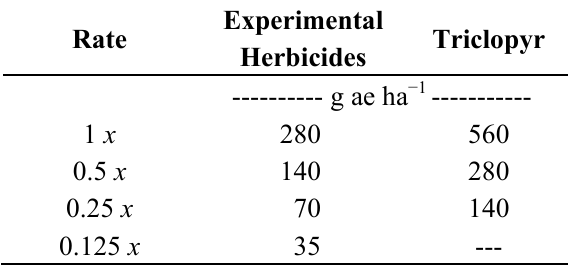
Table 2. Rates of herbicide acid equivalent used in the current study.